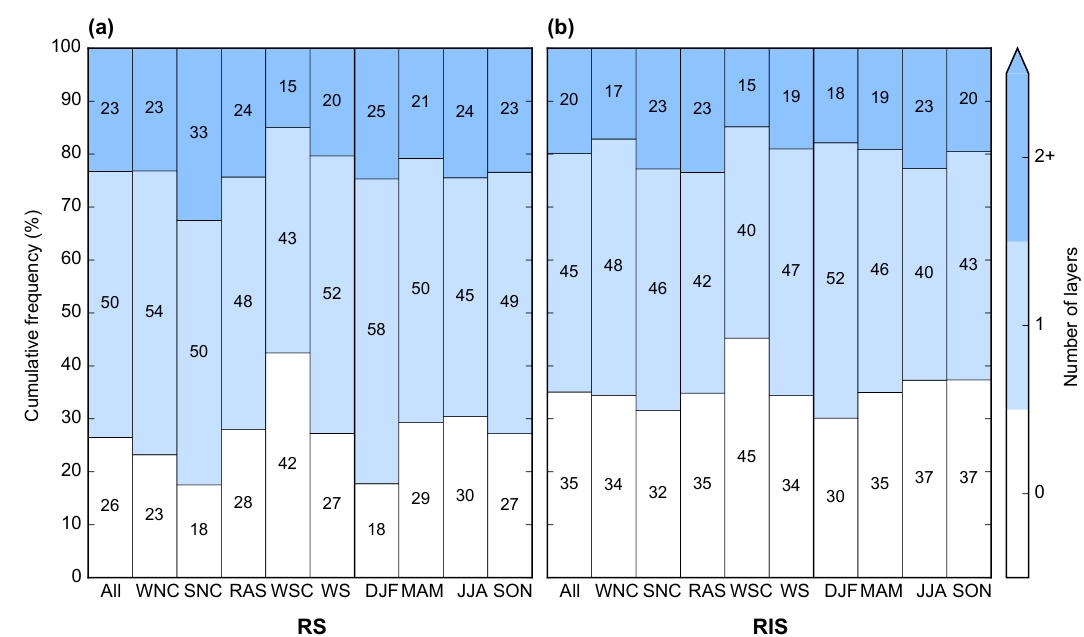
Figure 6. Distribution of the number of cloud layers over the Ross Sea and RIS for all cases, the Coggins regimes and